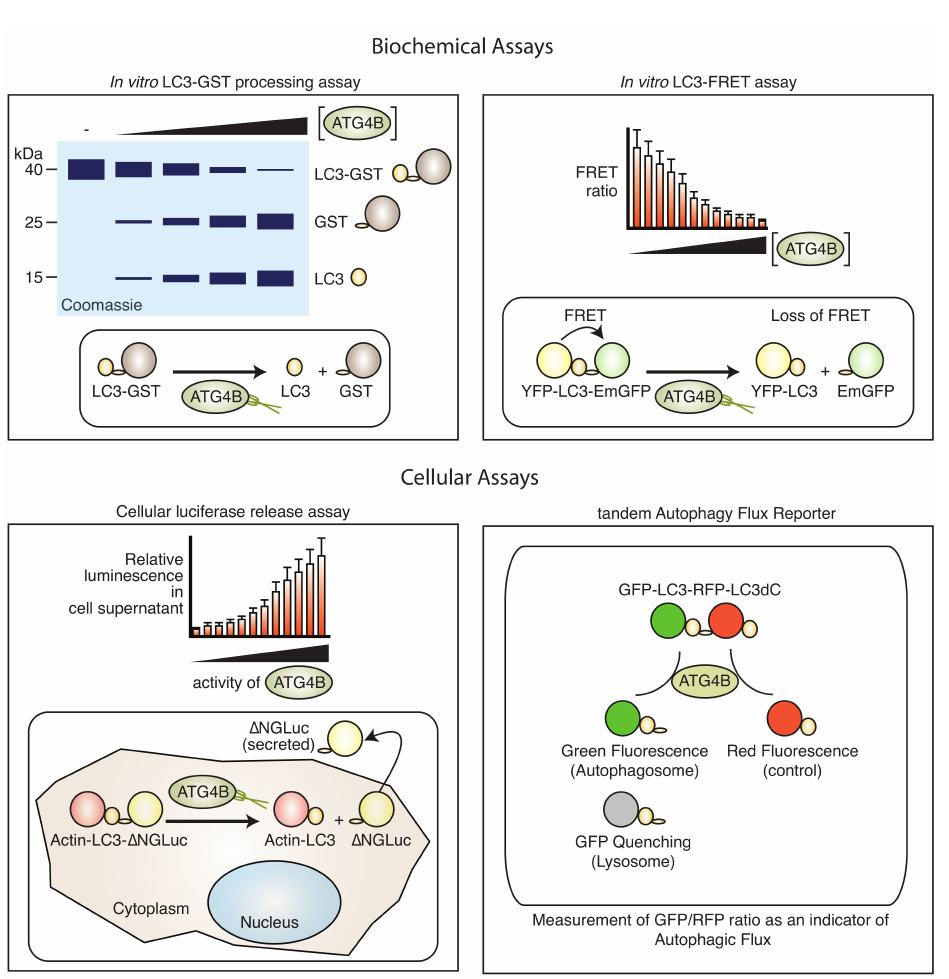
Figure 3. Biochemical and cell-based assays to monitor ATG4B activity. Biochemical assays such as the in vitro GST–LC3 processing assay (top left) that relies on poly-acrylamide gel electrophoresis